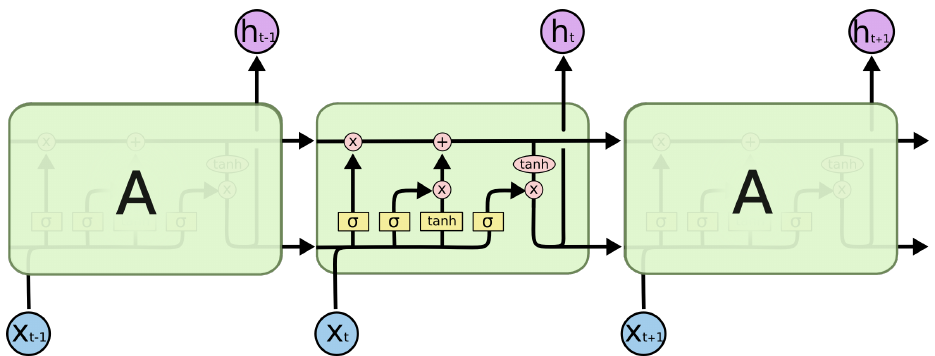
Figure 4. LSTM recurrent architecture (source: https://www.edureka.co) (accesed on 14 Febru- ary